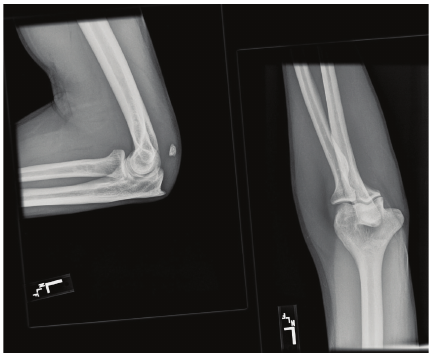
Figure 5: Plain radiograph, left elbow with avulsion fracture.